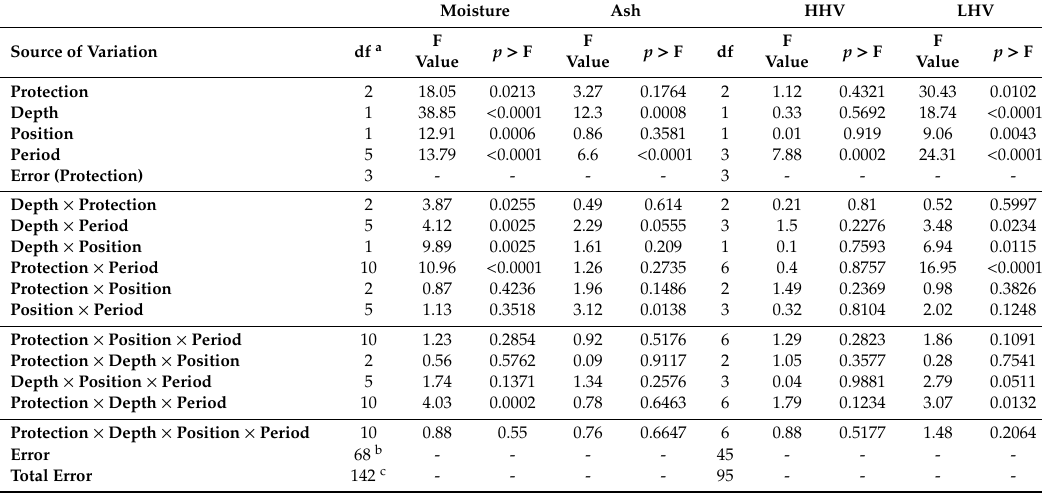
Table 1. Analyses of variance (ANOVA) for moisture, ash, higher heating value (HHV) and lower heating value (LHV) of willow and poplar chip piles that were sampled over six month period (June–October).